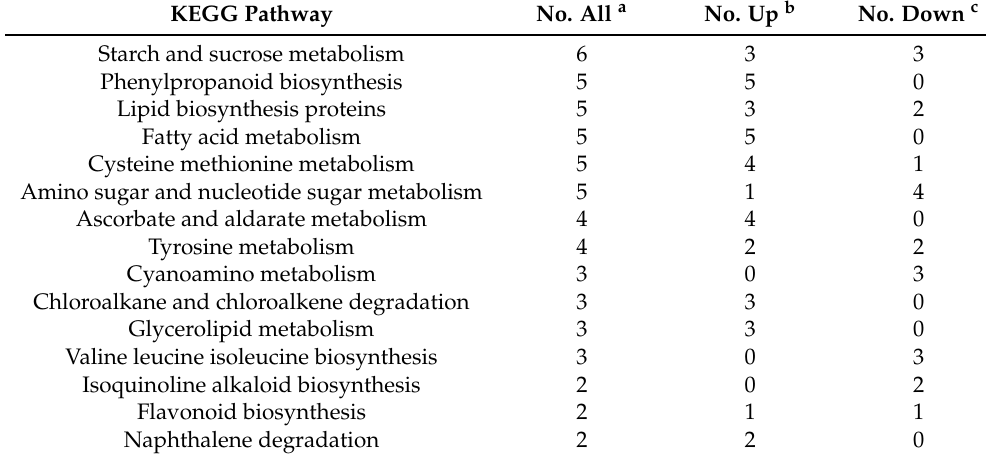
Table 1. Kyoto encyclopedia of genes and genomes (KEGG) pathway enrichment of the genes/proteins with a positive correlation ( p -value < 0.05, FC (pro) > 1.5, FC (RNA) > 2) between the levels of transcripts and proteins. KEGG Pathway No. All a No. Up b